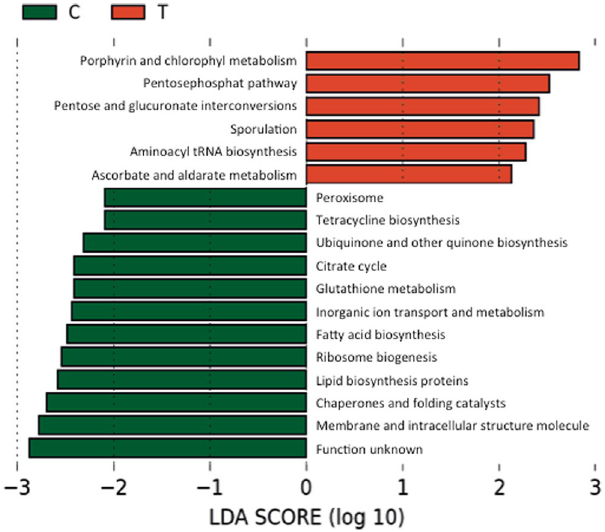
Figure 4. LEfSE analysis, indicating the potential presence of significantly different genomic/ functional capabilities of the microbiomes of tumour patients (red) and healthy controls